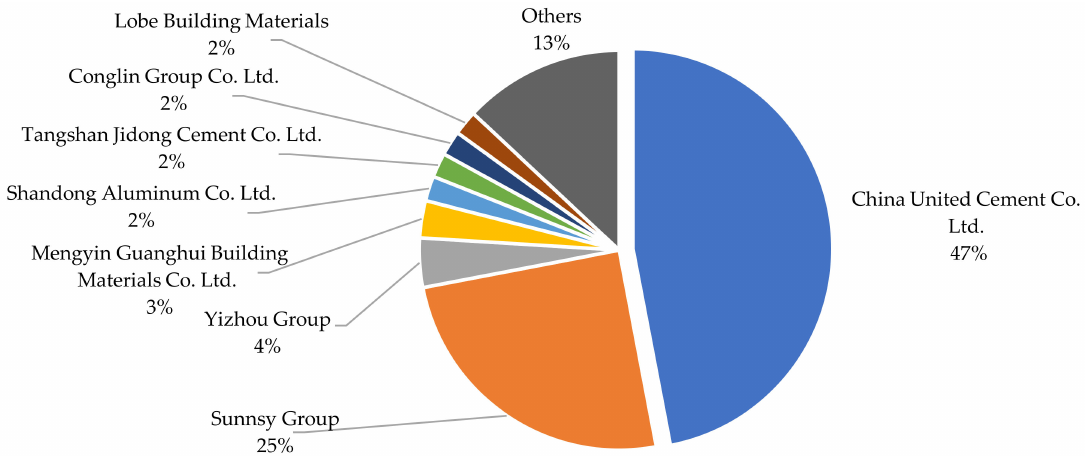
Figure 7. The output portions of major cement enterprises in